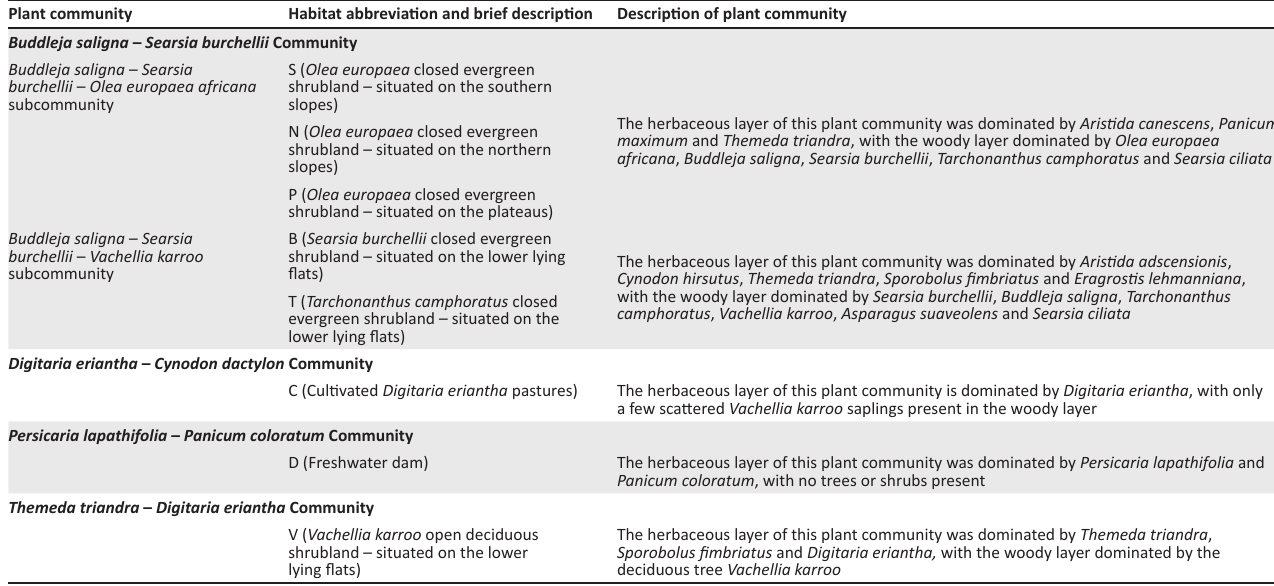
TABLE 1: Detailed description of plant communities in each of the habitats sampled in the Amanzi Private Game Reserve from September 2012 to August 2013. Plant